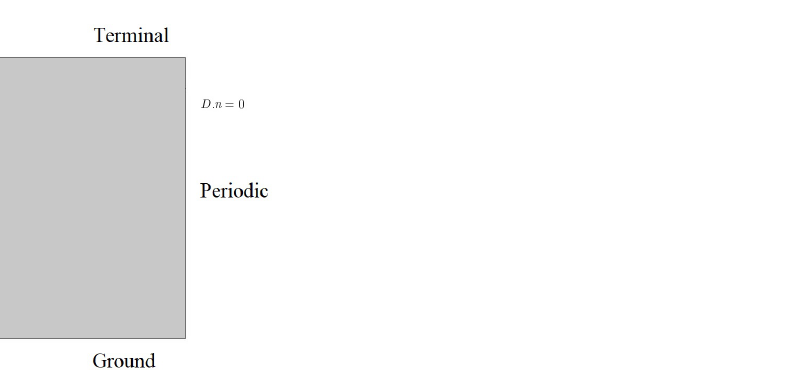
Figure 3. Schematic of BAW piezoelectric material (ZnO) and periodic condition (for real and imaginary k), terminal, and ground boundary condition at aluminum surfaces.